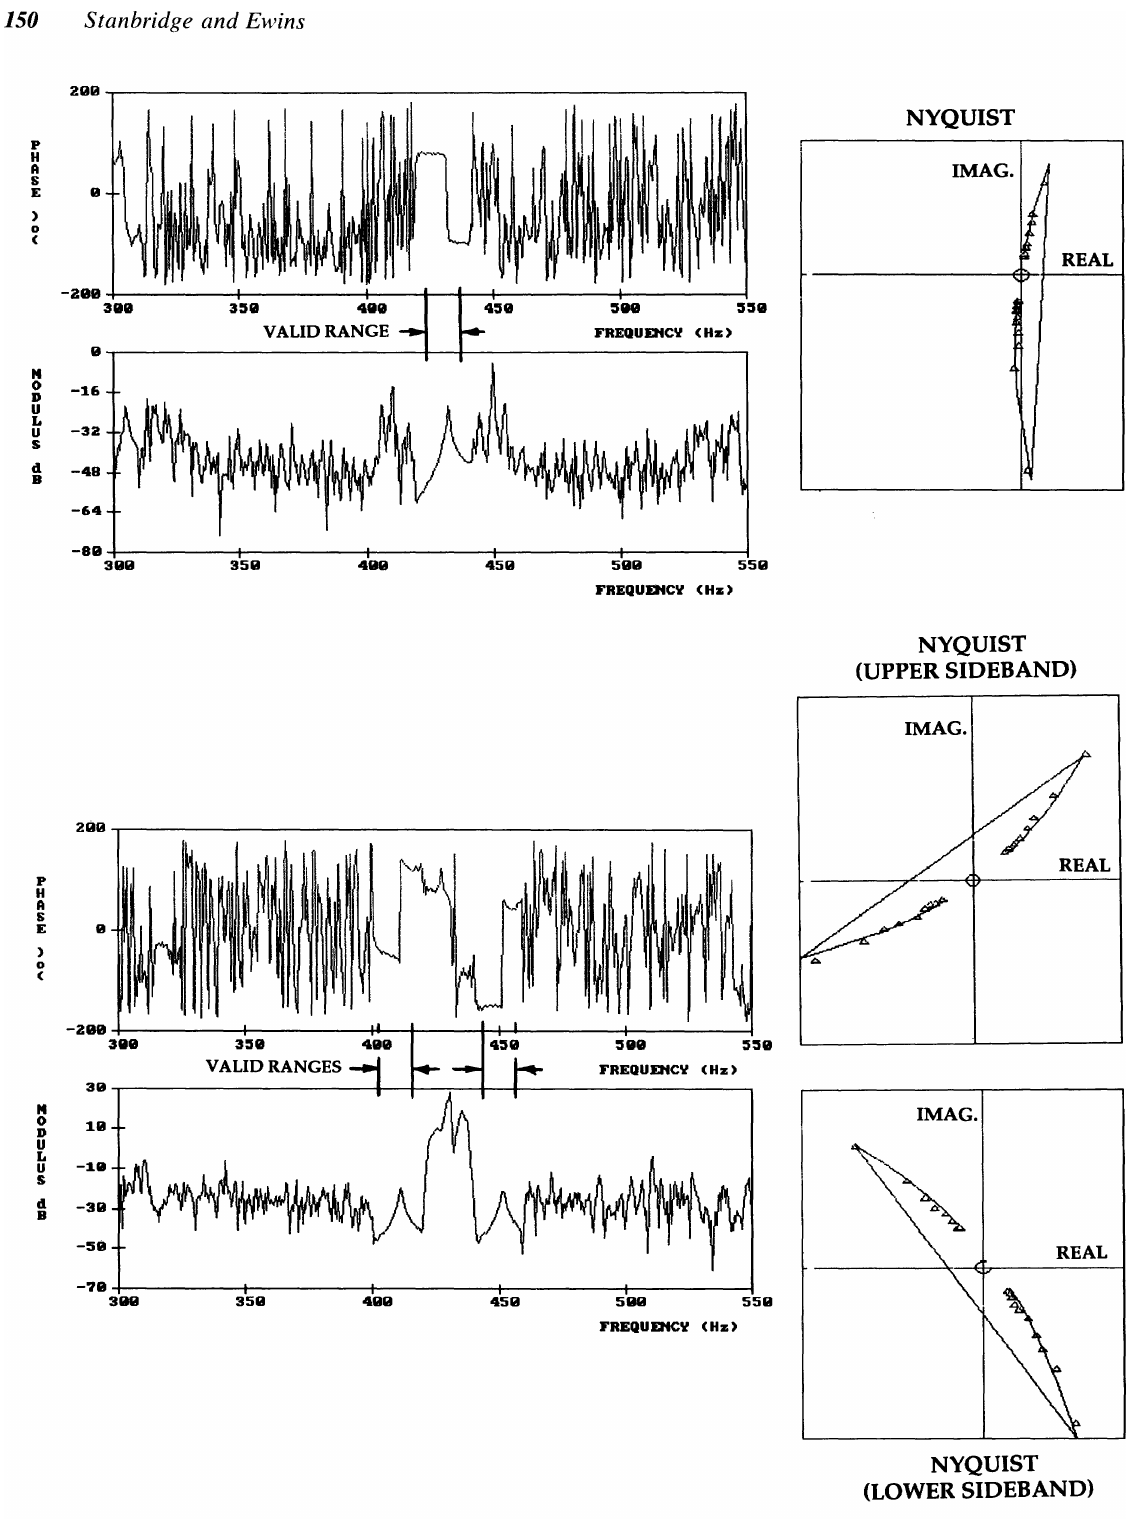
FIGURE 13 FRF spectra, beam in Fig. lOeb): (a) mobility (LDV response/force) and (b) LDV response/multiplier